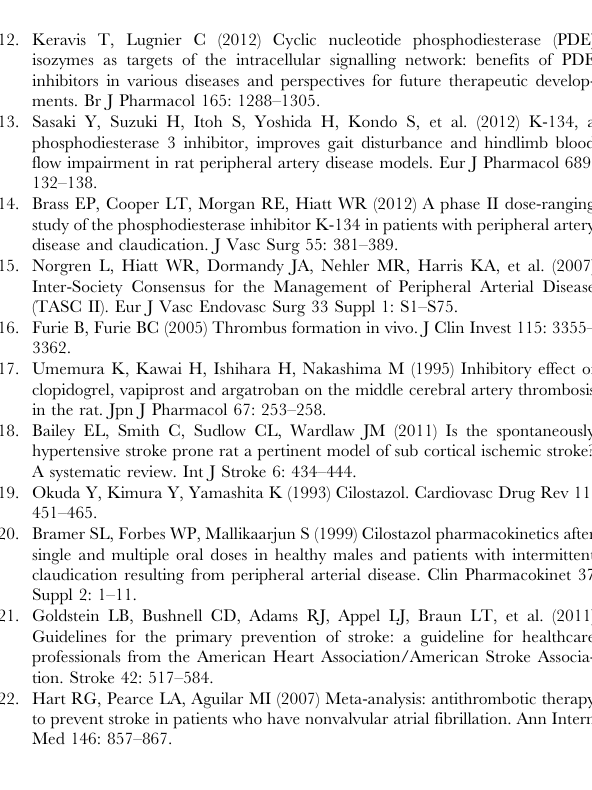
Figure S1 Antiplatelet effects of cilostazol ex vivo in rats. Antiplatelet effects of cilostazol were investigated ex vivo. Three hours after administration of cilostazol, blood was collected for preparing platelet-rich plasma. Platelet aggregation was induced by ADP (A) or collagen (B), and inhibitory effects were estimated by measuring the AUC during the 5 or 7 min after addition of ADP or collagen, respectively. Values are means 6 SEM (*P , 0.05, ***P , 0.001 vs. vehicle control, two-tailed Dunnett’s test, n= 8). Figure S2 Inhibitory effects of PDE3 inhibitors on mouse platelet aggregation in vitro. Citrated PRP derived from mice was preincubated with K-134 or cilostazol, and stimulated with collagen (A) or ADP (B). Inhibitory effects of agents on collagen (A) and ADP (B) were estimated by measuring the AUC during the 5 min after stimulation. Values are means 6 SEM (*P , 0.05, **P , 0.01, two-tailed Dunnett’s test, n= 5). (TIF) Figure S3 Bleeding time in mice. K-134 and warfarin were administered to mice at 10 min and 24 h before testing of tail bleeding time, respectively. Values are means 6 SEM (n= 27–28). **P , 0.01 vs. vehicle control by two-tailed t-test. N.S. = not significantly different by two-tailed Dunnett’s test. (TIF)